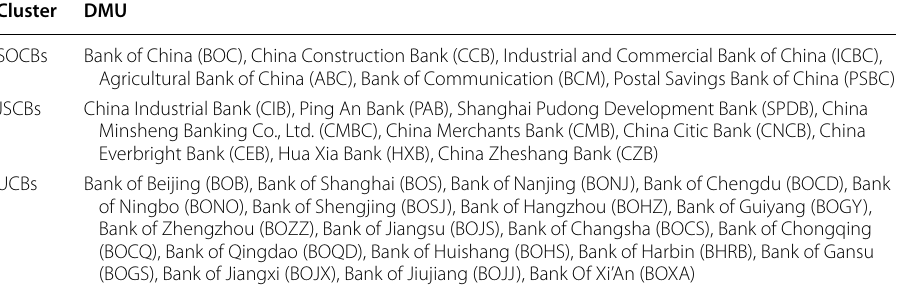
Table 2 Classification of 34 Chinese Commercial Banks Cluster DMU